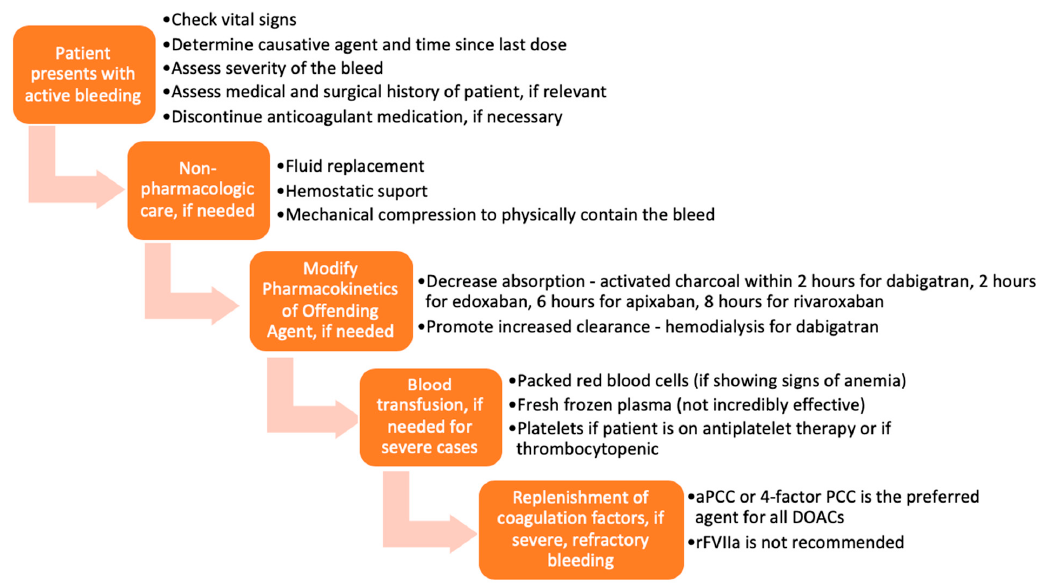
Figure 2. Flow chart of management of bleeding, before the approval of idarucizumab and andexanet alfa.